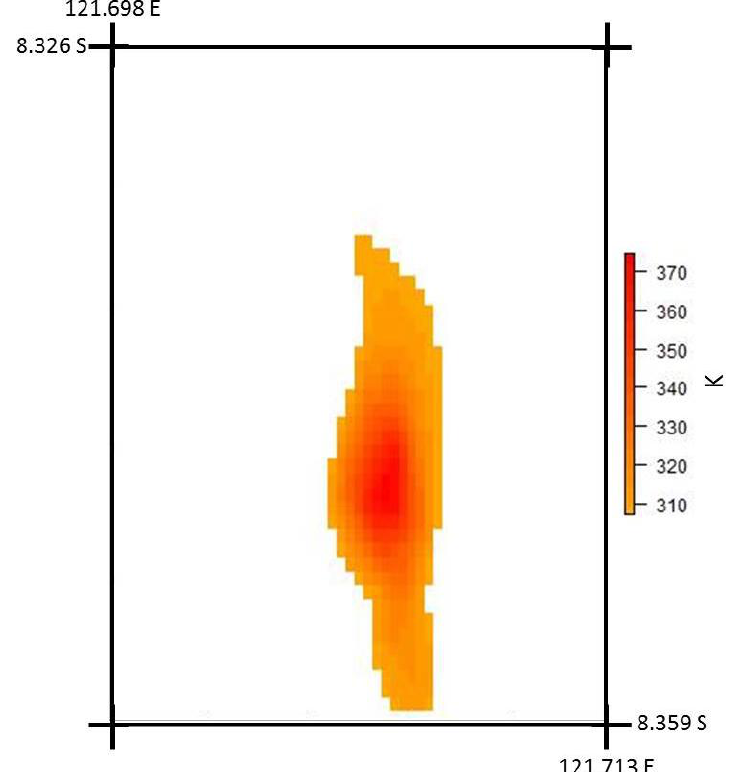
Figure 5. The brightness temperature of pixels isolated as anomalous within the region of extracted thermal anomaly for the TIRS band 10. The region for which data are represented here relates to that outlined in blue in Figure